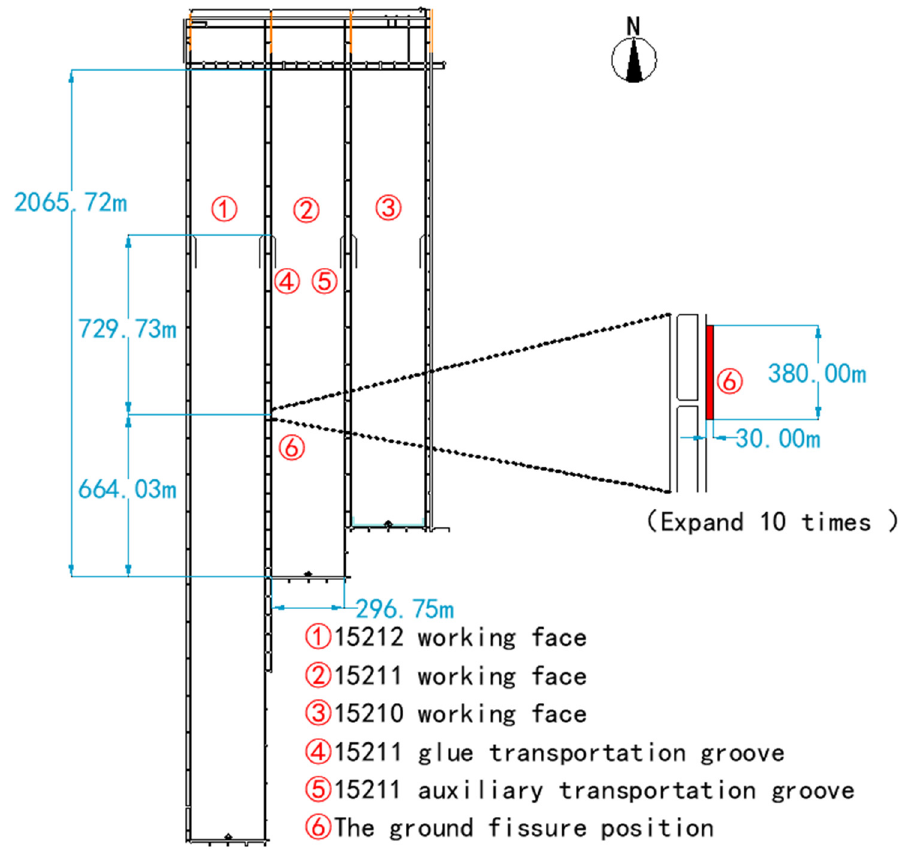
Figure 2. Position relationship between the ground fissure and the working